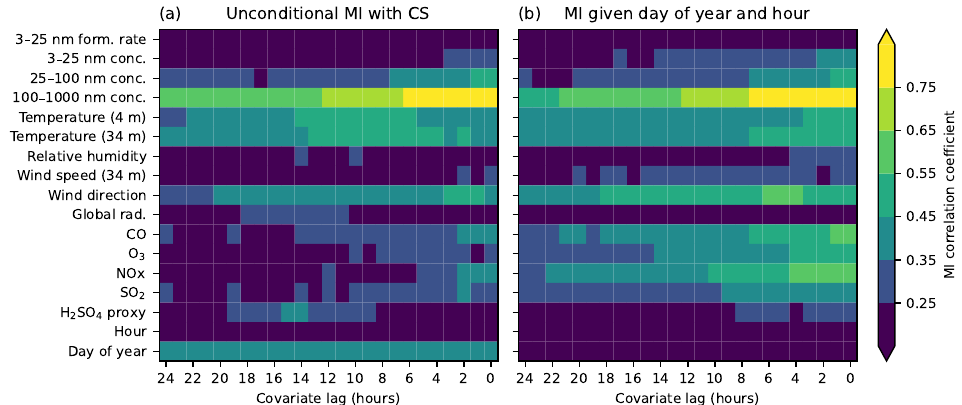
Figure 9. Correlation coefficients between studied variables and the condensation sink (CS) as function of the lag time for ( a ) unconditional MI and ( b ) conditioning on season and time of day. Covariates are measured at times up to 24 h before the CS observation. The correlation with sulfuric acid proxy is most likely explained by similar diurnal variation, as it is reduced by conditioning on the time of